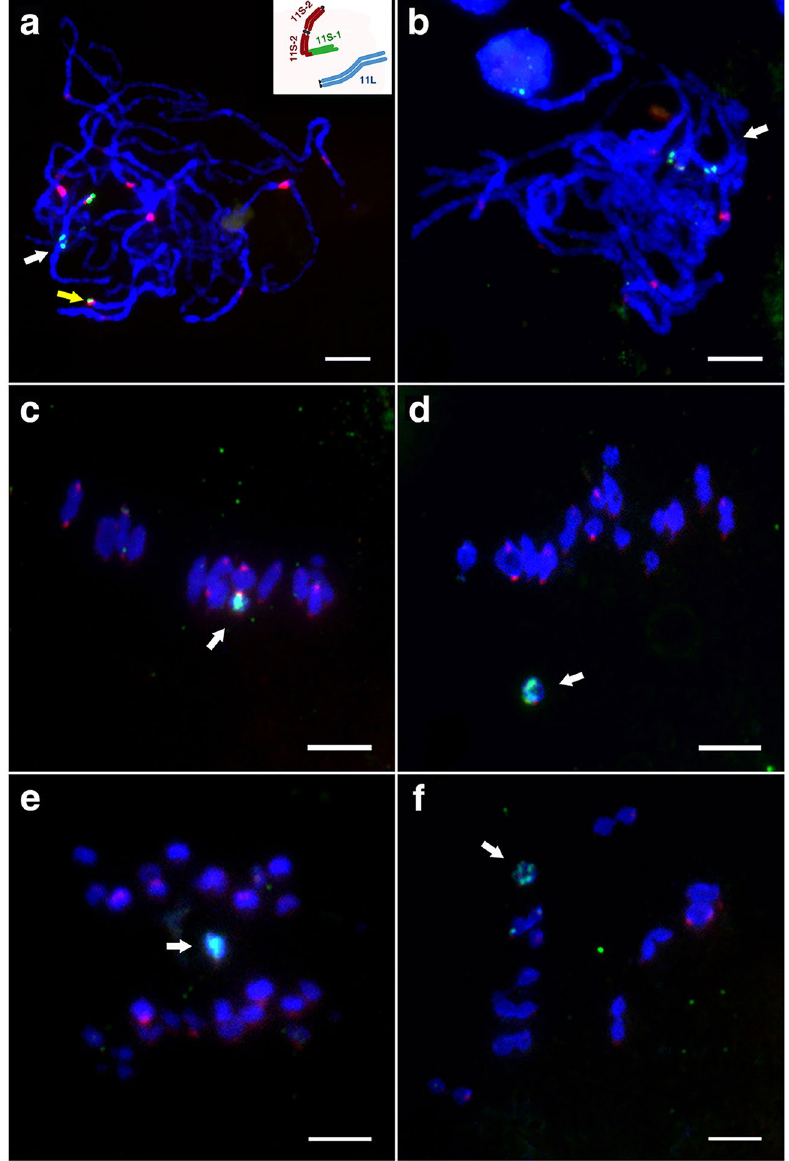
Figure 5. Behavior of the structurally tricentric chromosome at meiosis in variant YZG-5. Chromosomes were counterstained with DAPI. White arrows show the structurally tricentric chromosome 11S∙11S∙11S∙11S. Red signals indicate CentO and green signals indicate 5S rDNA. Scale bars represent 5 μ m in all images. ( a , b ) Synapsis of the 11th homologous chromosomes at meiotic prophase I. ( a ) The structurally tricentric chromosome 11S∙11S∙11S∙11S (white arrow) and two 11L∙ (yellow arrow) exhibited bivalents respectively, with the illustration of the state of 11S∙ and 11L∙. ( b ) Synapsis of the chromosome 11S∙11S∙11S∙11S indicated no obvious bivalent structure. ( c ) The structurally tricentric chromosome with 5S rDNA signal did not divide at meiotic metaphase I. ( d ) The structurally tricentric chromosome with 5S rDNA signal was not involved in the arrangement of chromosomes on the equatorial plate at meiotic metaphase I. ( e ) At meiotic anaphase I, the lagging chromosome was on the equatorial plate. ( f ) At meiotic anaphase I, the structurally tricentric chromosome was distributed to one daughter